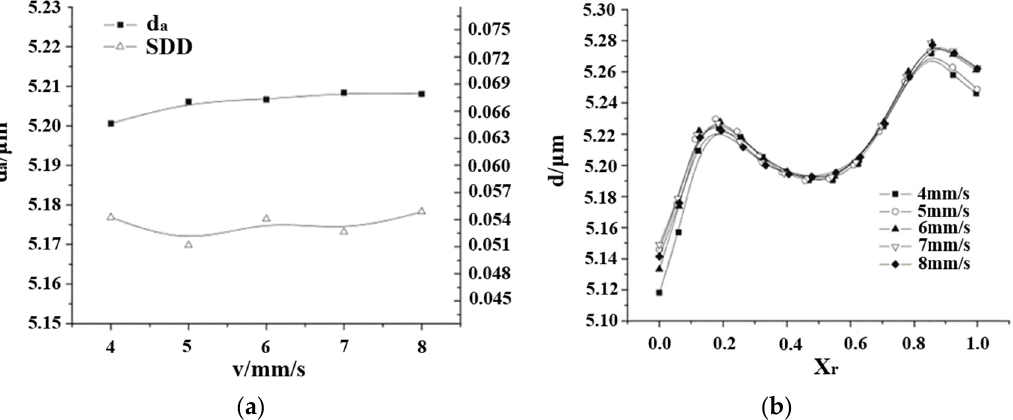
Figure 7. Variation of β grain size with feed rate of idle roll: ( a ) average grain size d a and uniformity of β grain size distribution SDD; ( b ) d distribution along radial direction of ring with permission from [54], 2013, Springer.